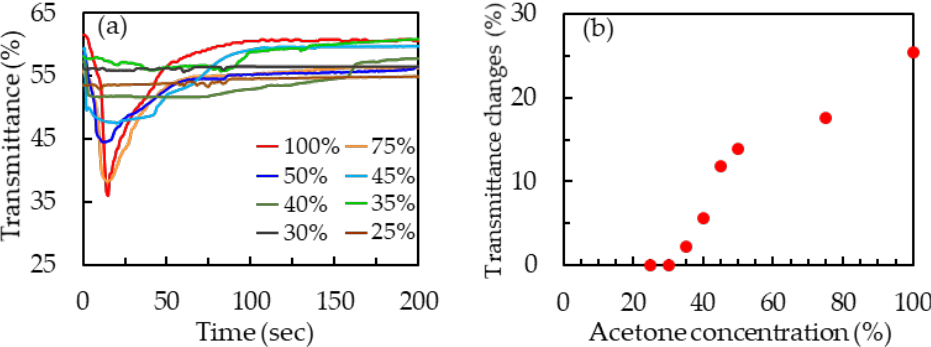
Figure 7. ( a ) Time-dependent transmittance curves of 50-μm-thick patterned PDLC films that were exposed to acetone solutions with concentrations of 25 v%, 30 v%, 35 v%, 40 v%, 45 v%, 50 v%, 75 v%, and 100 v%. ( b ) Transmittance changes of 50-μm-thick patterned PDLC films at acetone solu- and 100 v%. ( b ) Transmittance changes of 50- µ m-thick patterned PDLC films at acetone solutions tions with various concentrations. with various